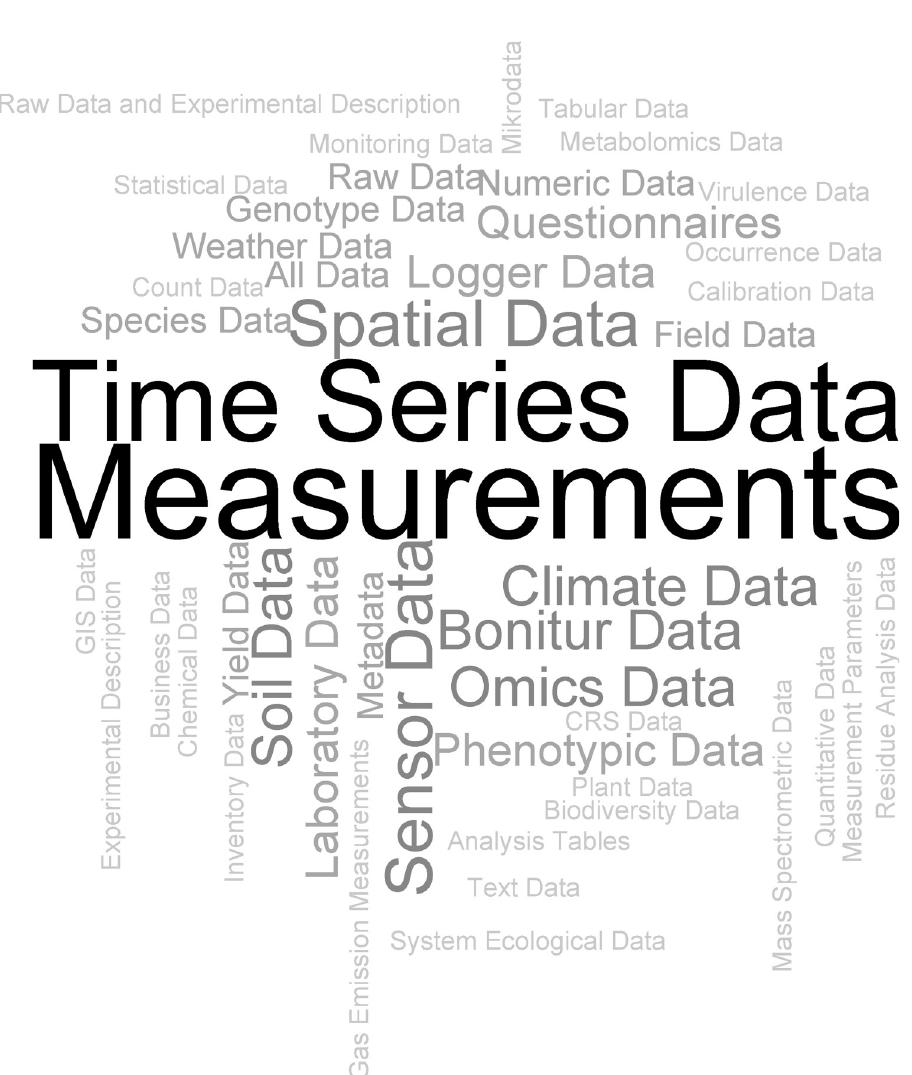
Fig 5. Wordcloud with data for which the respondents could imagine using a validation tool. The size represents the frequency with which individual data types were mentioned, e.g. “measurements” was mentioned twelve times (respondents N = 66, 104 mentioned data types, 47 different data types;